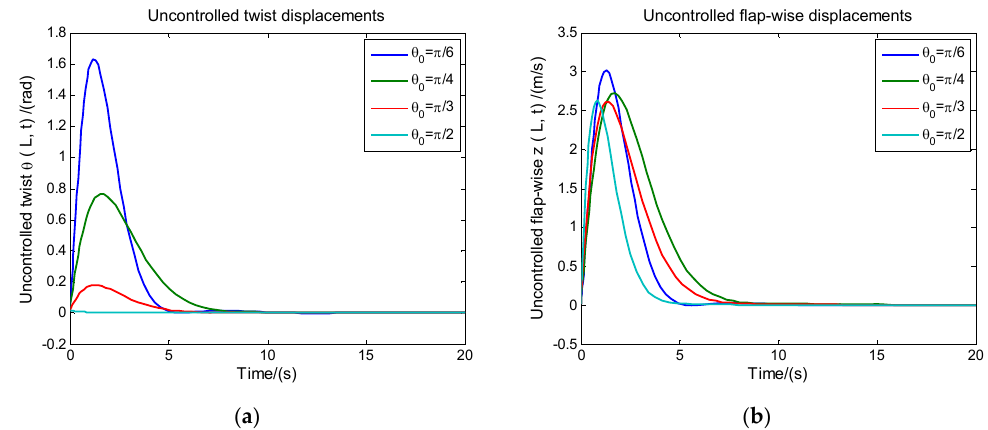
Figure 3. The uncontrolled twist / flap-wise displacements under conditions of ply angles θ = π /6, π /4, π /3, π /2, respectively: ( a ) The uncontrolled twist displacement; ( b ) The uncontrolled flap ‐ wise displacement.